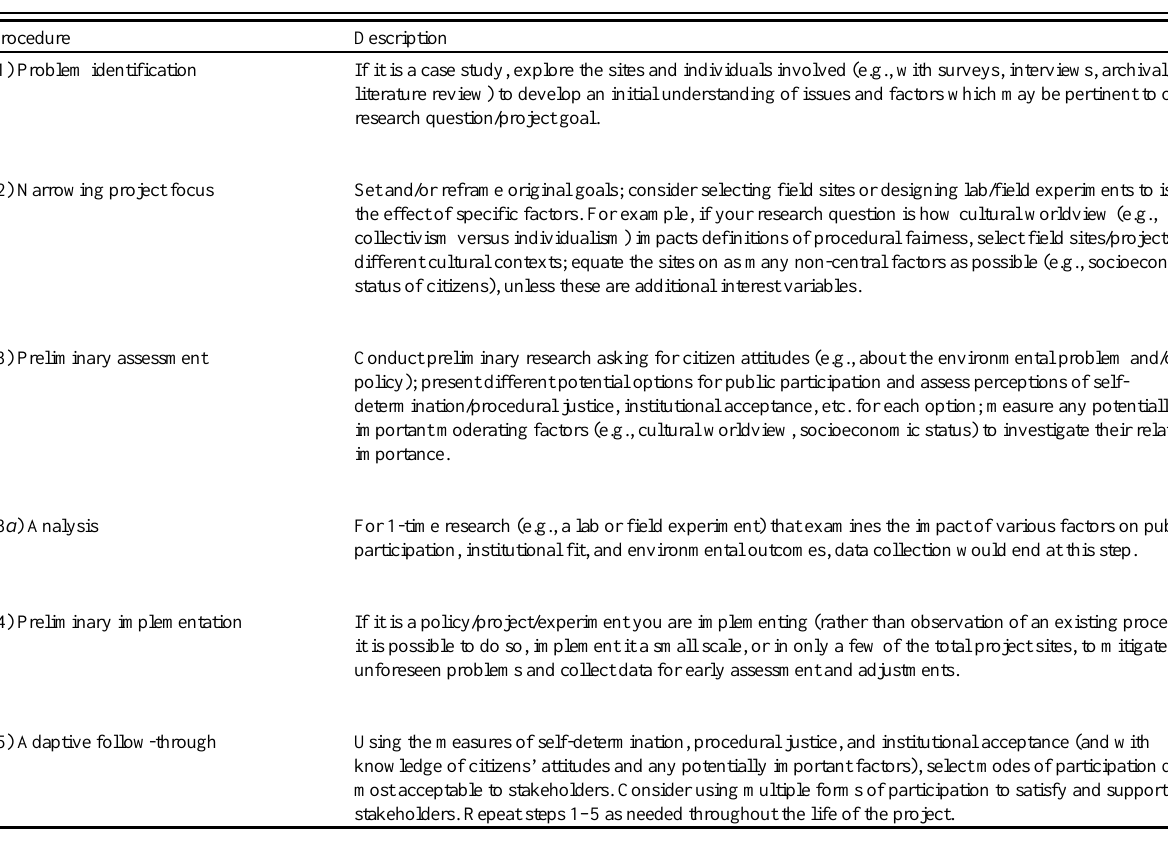
Table 2 . General procedures for diagnosing participatory fit.